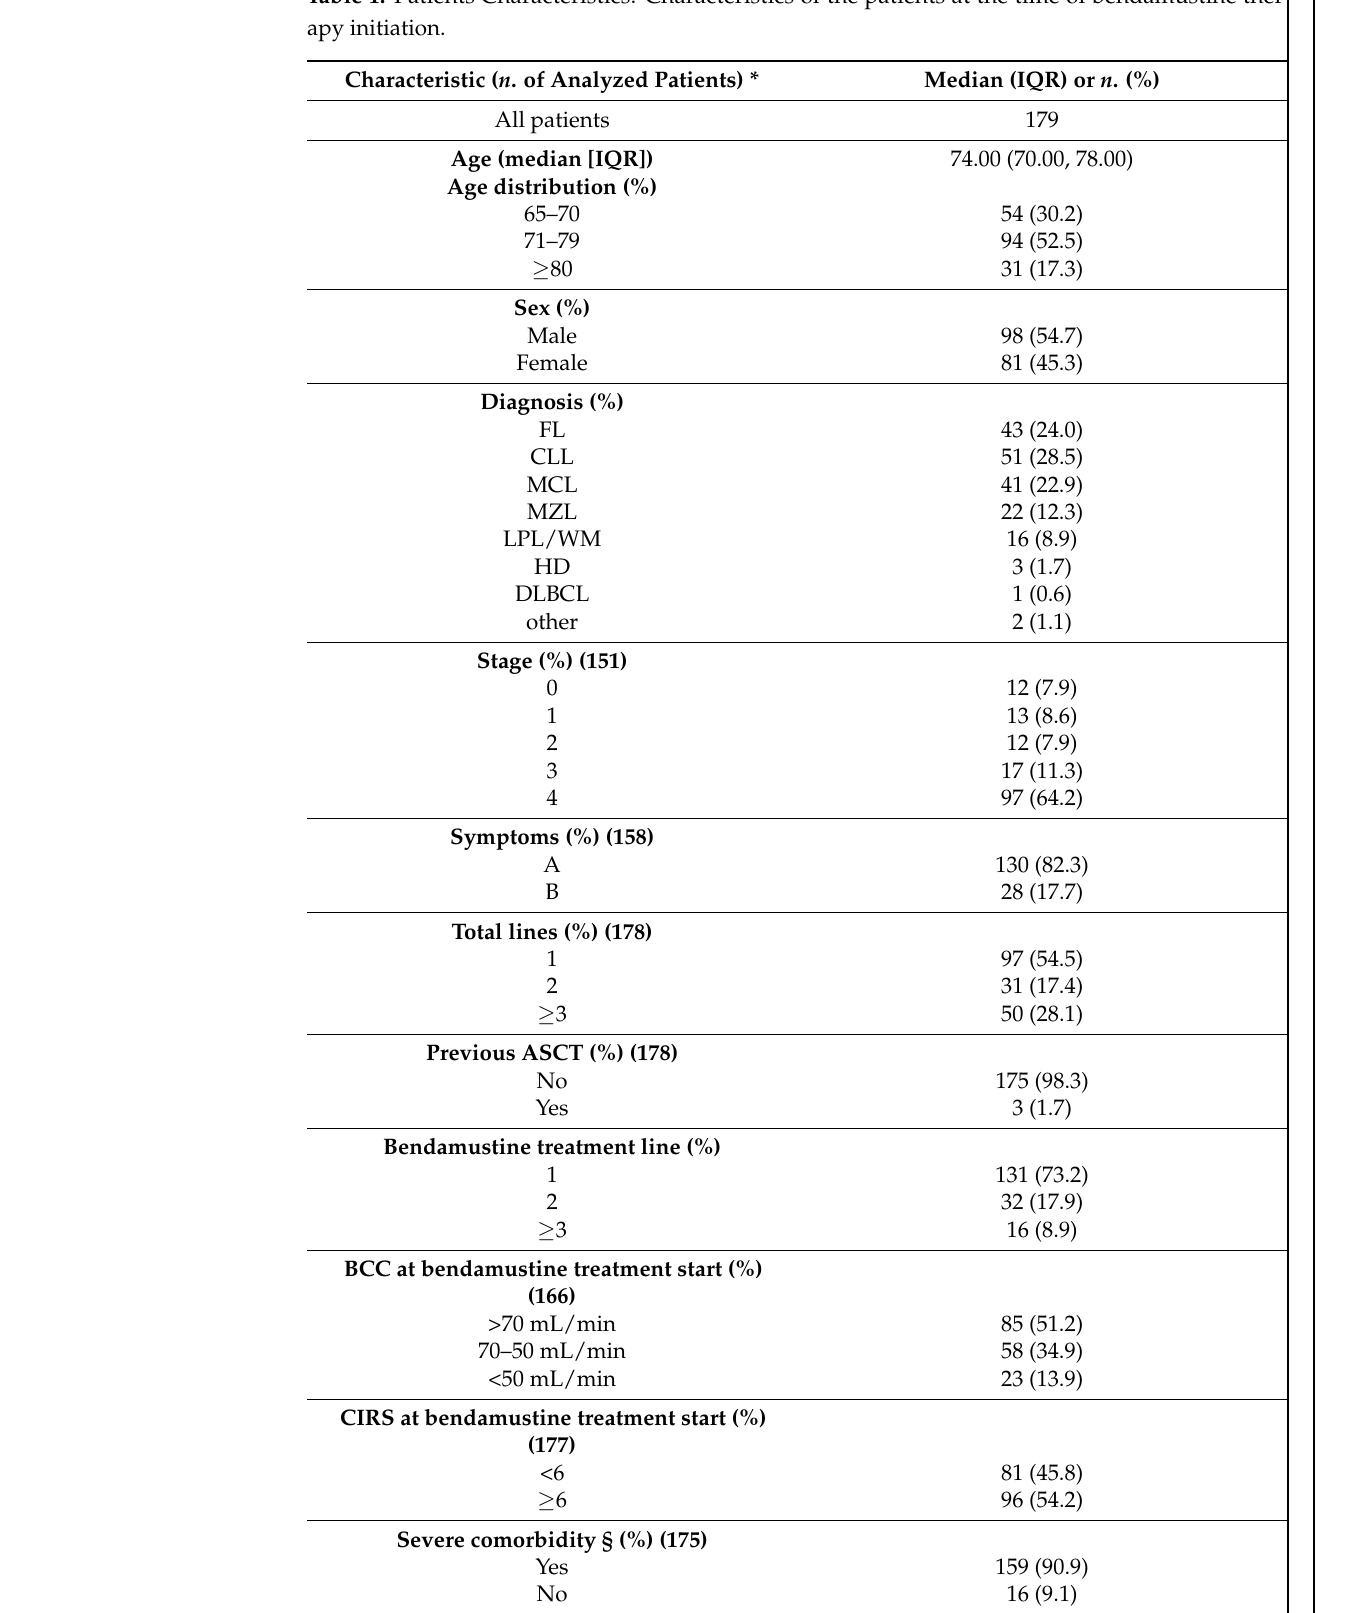
Table 1. Patients Characteristics. Characteristics of the patients at the time of bendamustine ther- apy